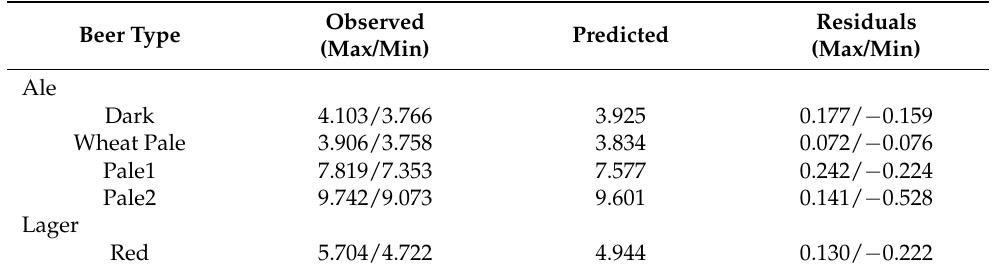
Table 6. Total content of BAs (mg L − 1 ) observed for craft beers and predicted values from the proposed GLSR